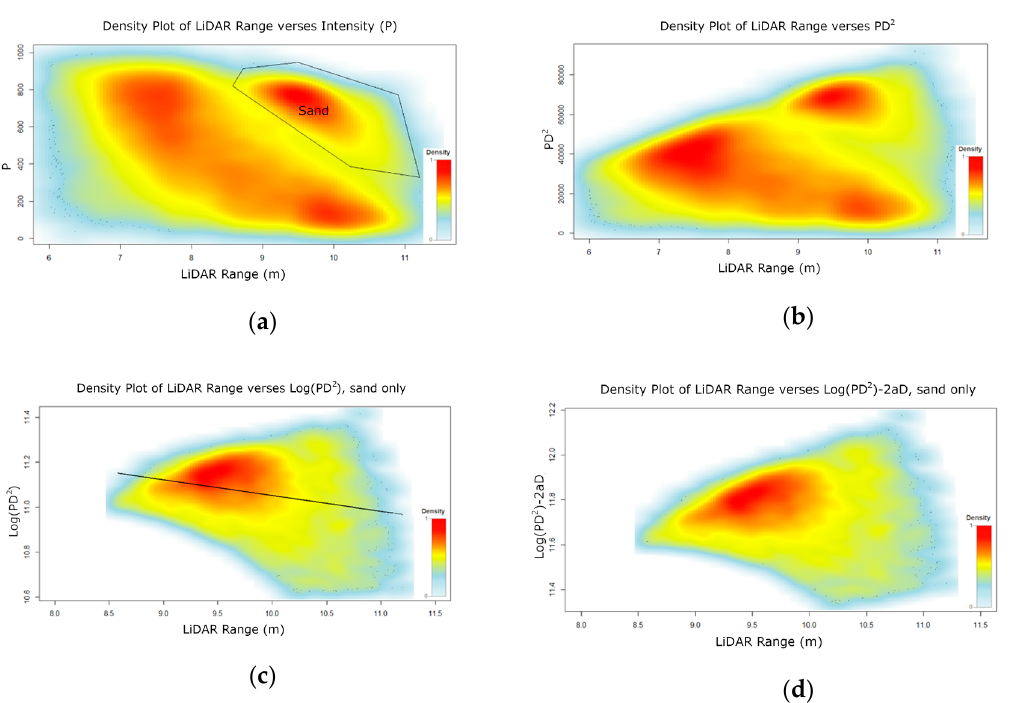
Figure 9. Density plots of ( a ) provided intensity (P) vs LiDAR range (sand pixels enclosed in polygon), ( b ) 𝑃𝐷 (cid:2870) vs LiDAR range, ( c ) 𝑙𝑜𝑔 (𝑃𝐷 (cid:2870) ) vs LiDAR depth for sand pixels only (with fitted line), and ( d ) 𝑙𝑜𝑔 (𝑃𝐷 (cid:2870) ) − 2𝑎𝐷 vs LiDAR range.